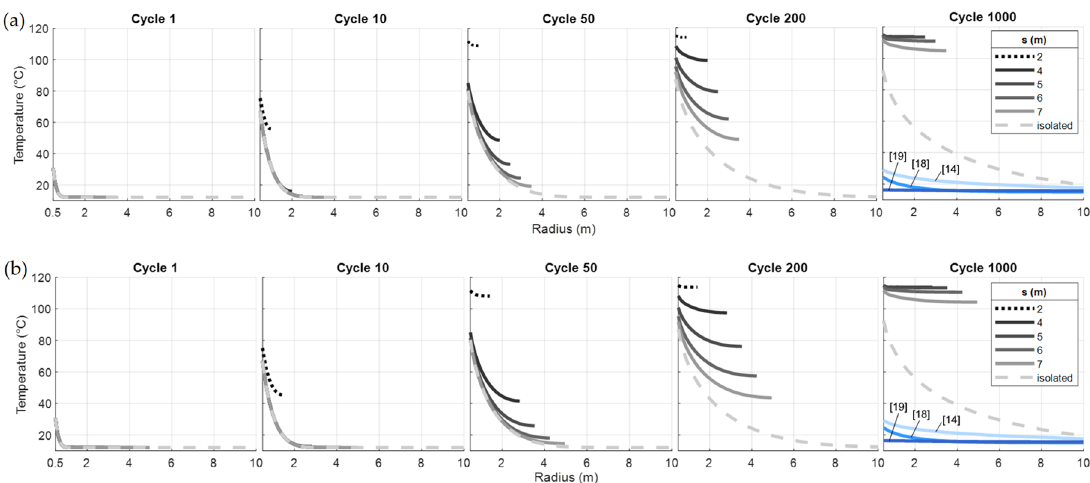
Figure 13. Temperature distribution along the soil section for different s at the end of the 1st, 10th, 50th, 200th, and 1000th loading cycles for ( a ) θ = 0° and ( b ) θ = 45°.